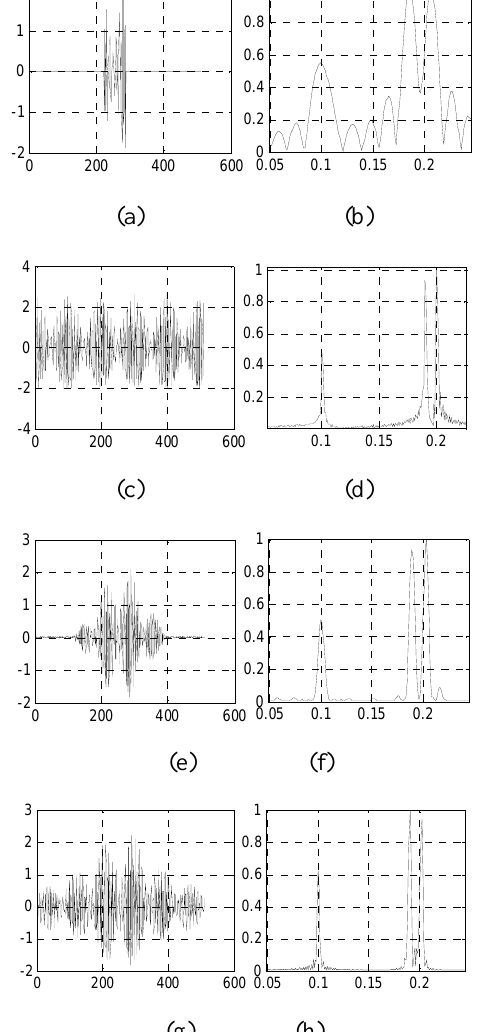
Fig.2. 1-D complex sinusoid example. (a) Original signal. (b) Frequency spectrum of (a). (c) Actual 512 samples signal. (d) Frequency spectrum of (c). (e) Extrapolated signal using AWNE method. (f) Frequency spectrum of (e). (g) Extrapolated signal using paper’s method. (h) Frequency spectrum of (g).